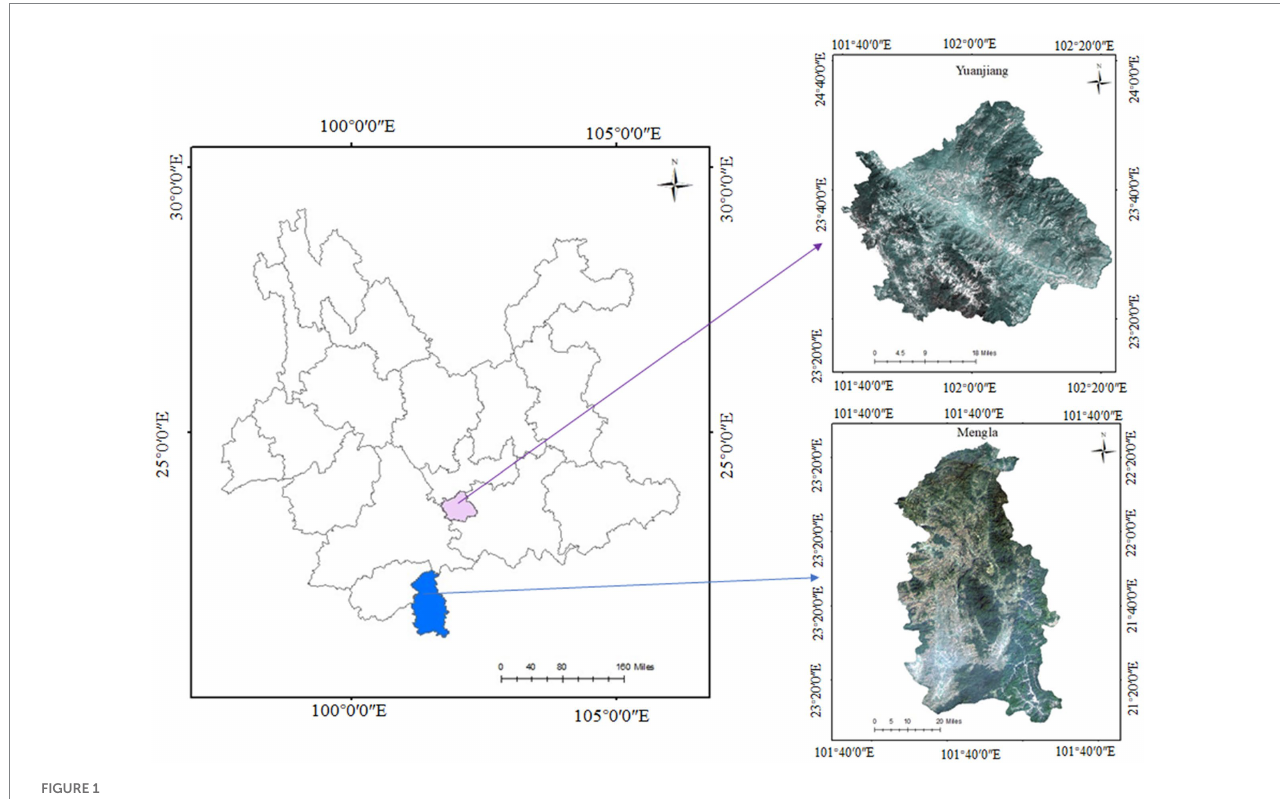
FIGURE 1 Location of the study